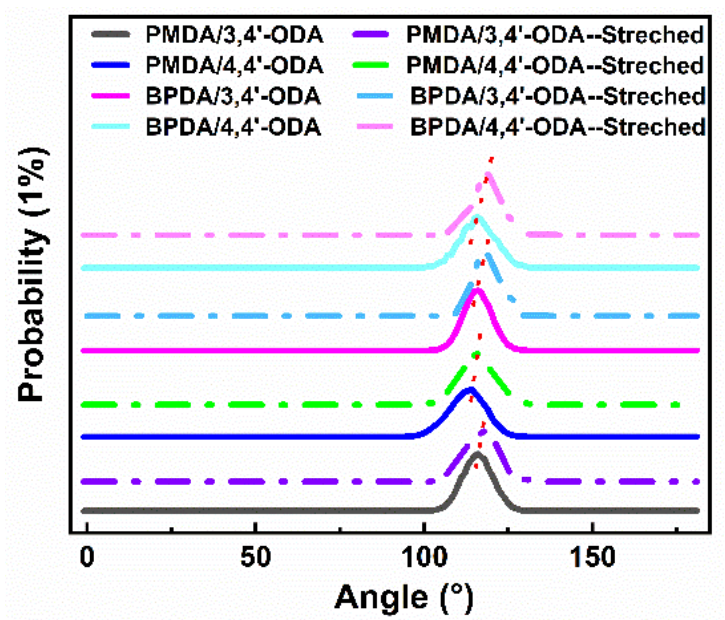
Figure 10. Angle changes of C-O-C in ODA before and after stretching of different systems of PI.